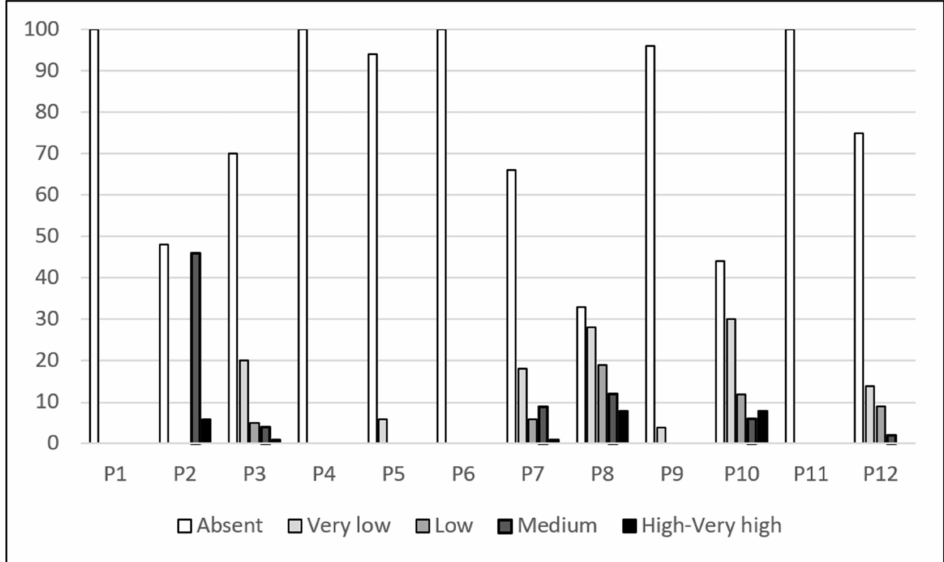
Figure 2. Incidence of C. undatus in percentage of trees per plot (P) showing different damage intensity.